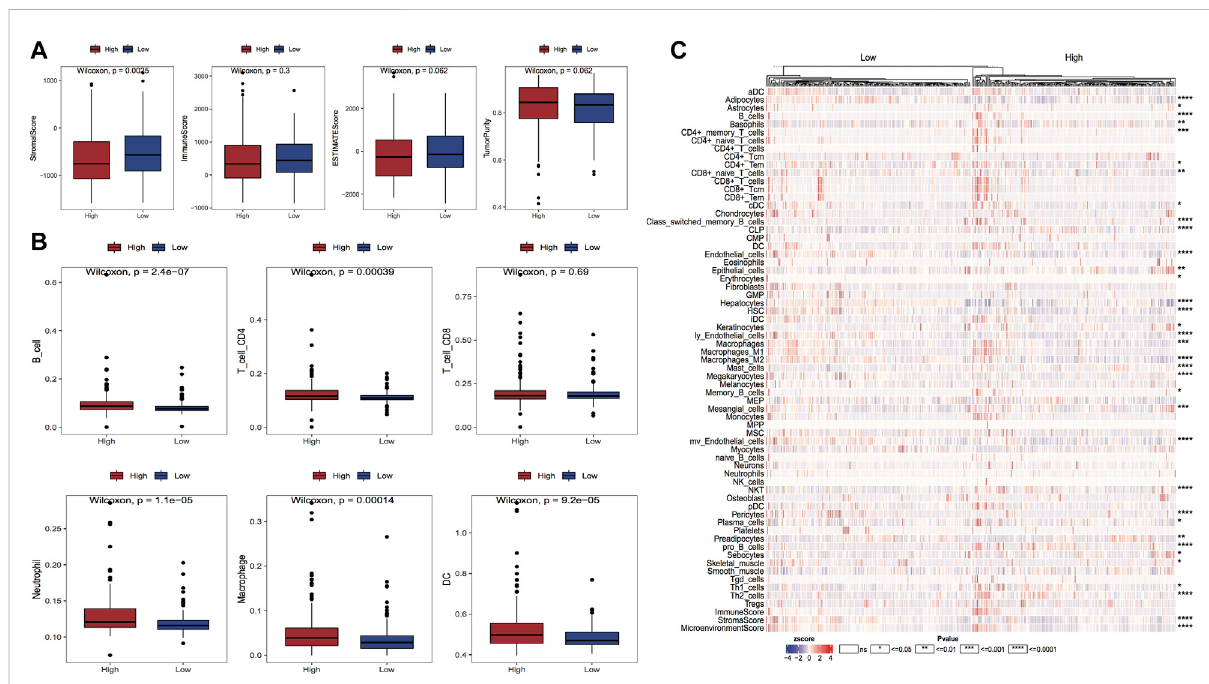
FIGURE 10 Variations in the proportion of immune in fi ltrating cells betweenmodel subgroups. (A) Box line plots of matrix score, immune score, ESTIMATE score and tumor purity for high and low-risk groups, respectively, red for high-risk group and blue for the low-risk group; (B) Box line plots of the proportion of immune in fi ltrating cells for high and low-risk groups in TIMER algorithm, red for high-risk group and blue for the low-risk group; (C) Thermographic of the variation in the abundance of immune in fi ltrating high and low-risk groups in the xCell